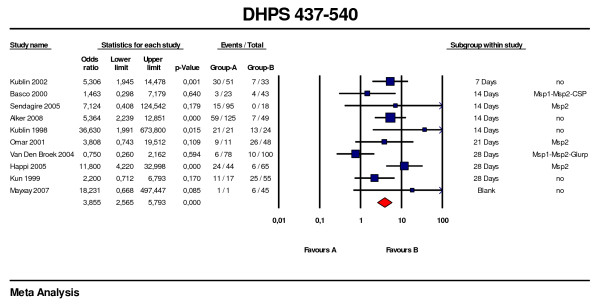
Pfdhps 437 – 540 predictive value of therapeutic failure with Sulfadoxine-pyrimethamine. Odds ratios (95% CI), forest plots and studies description are similar to previous figures. Studies were stratified according first to the duration of the follow-up, second to the use of genotyping for recrudescence, third to the date of publication.